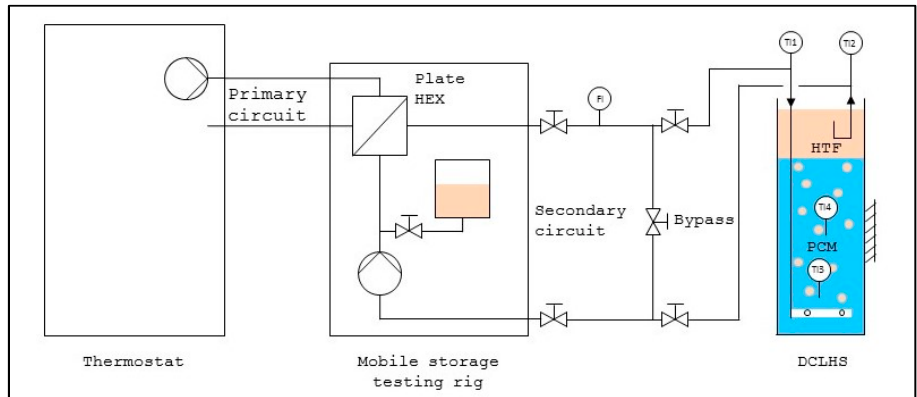
Figure 2. Schematic of the DCLHS system used at Lucerne University of Applied Sciences and Arts Reproduced with permission from [16], Ammann, A. Aufbau, Inbetriebnahme und Messungen an einem Latentwärmespeicher mit Direktkontakt-Wärmeübertragung. Master‘s Thesis, Hochschule Luzern HSLU, Lucerne, Switzerlan, 2017.